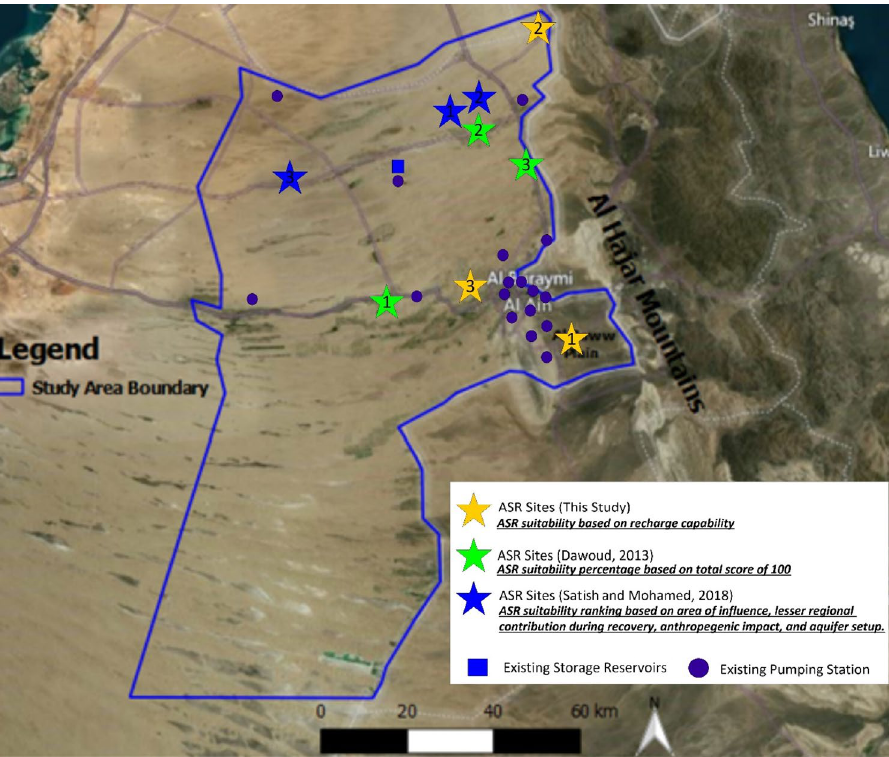
Figure 12. Suitable sites for the aquifer storage and recovery system for other studies and those identified in this